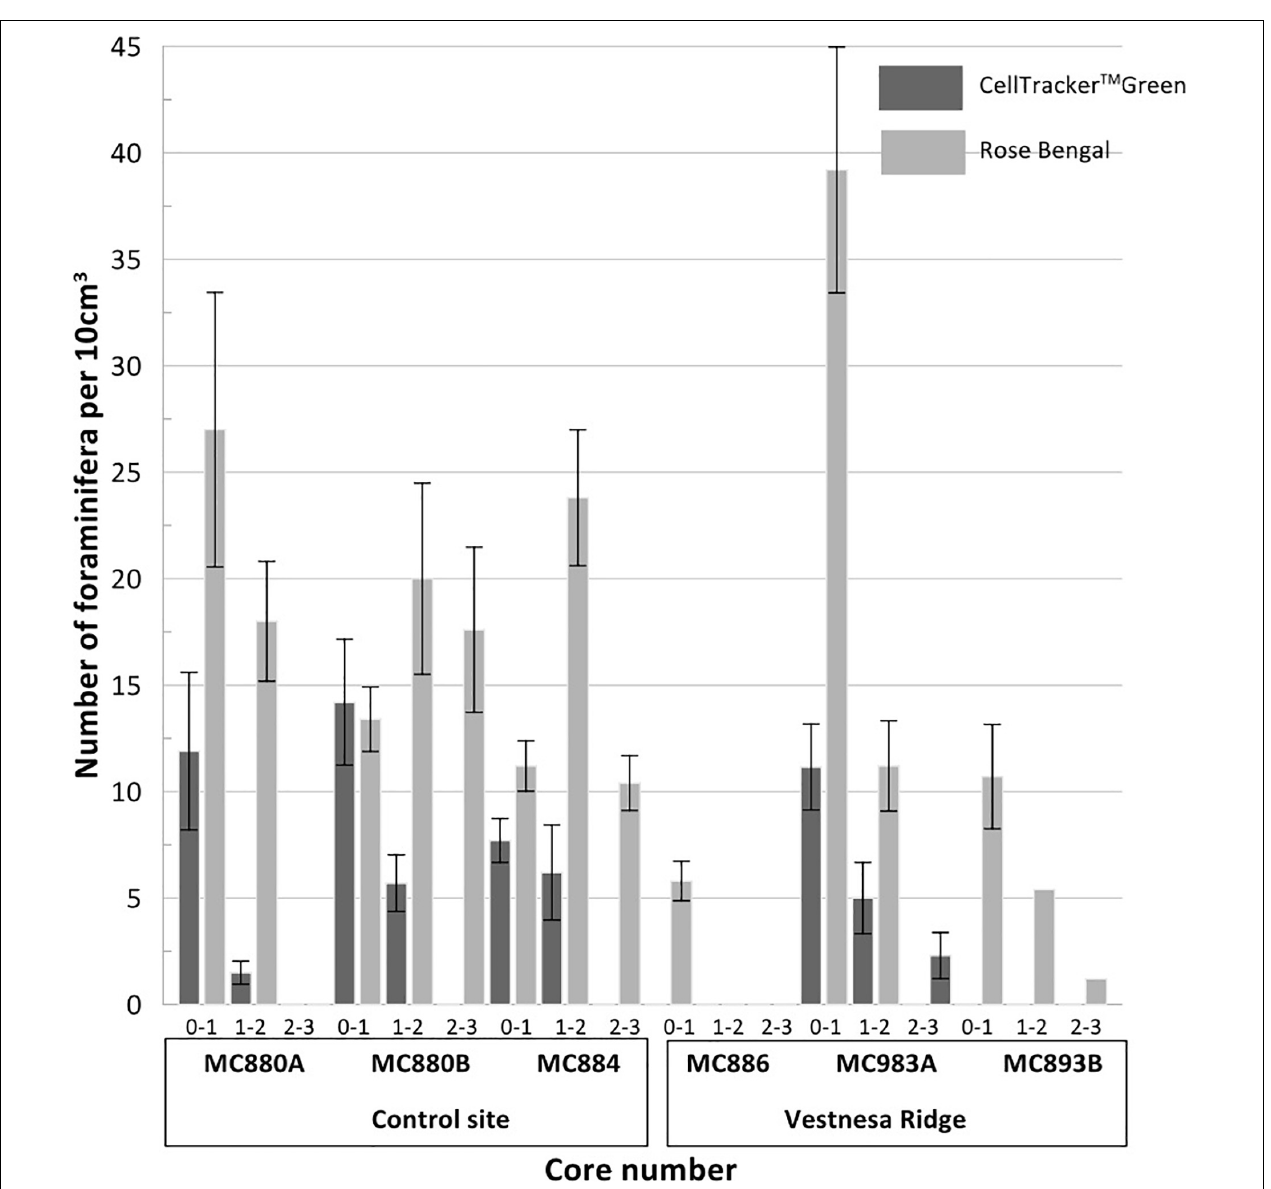
FIGURE 4 | Plots presenting the number (per 10 cm 3 ) of CellTracker TM Green CMFDA labeled (live) and Rose Bengal stained (live + recently dead) foraminifera from aliquots of Vestnesa Ridge and the nearby control site. Numbers 0–1, 1–2, and 2–3 next to the core number refer to the depth: 0–1, 1–2, and 2-3 cm respectively.